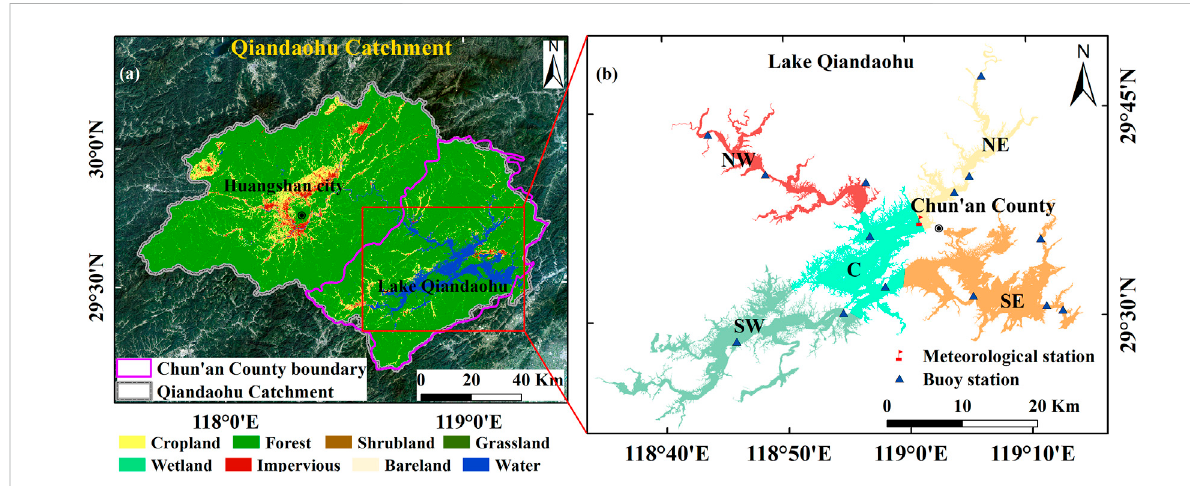
FIGURE 1 Locationandlandcover andlandusetypesoftheQiandaohucatchment (A) andthespatial distributions ofbuoysandmeteorological stationin Lake Qiandaohu (B)